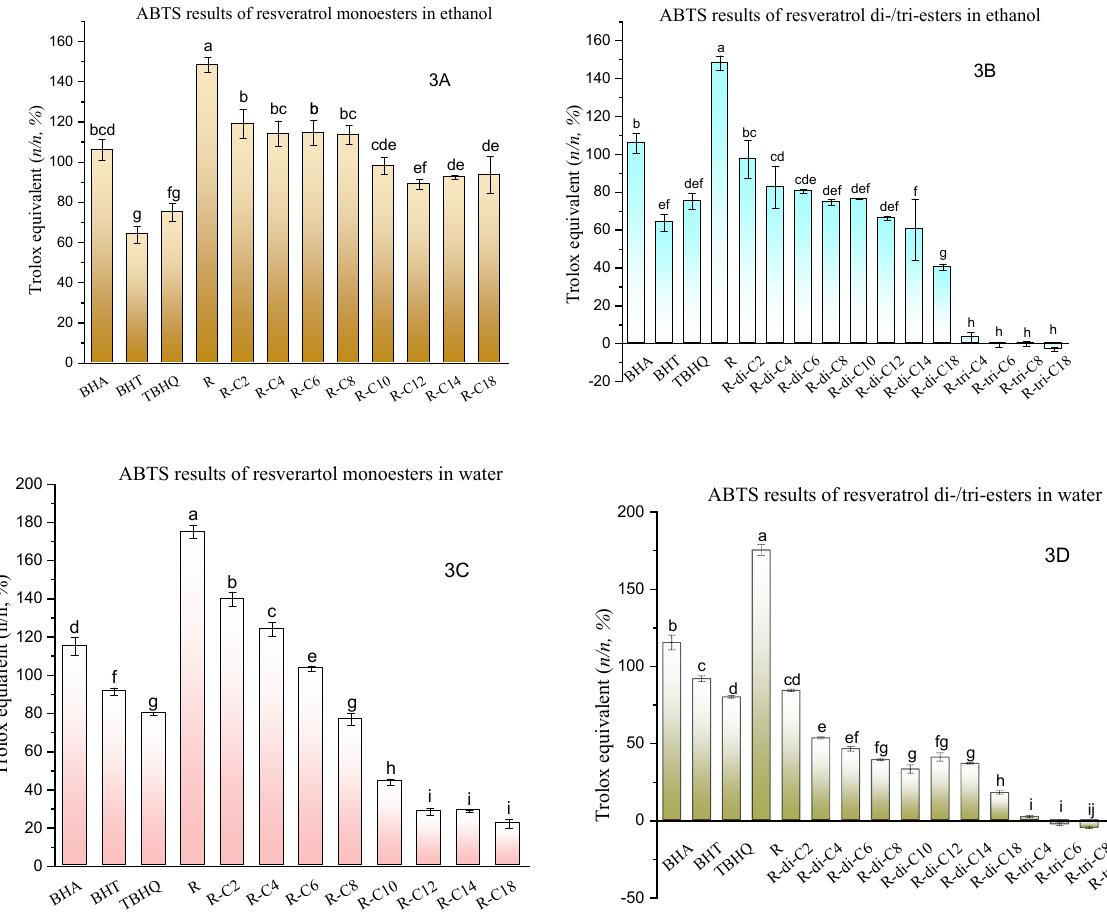
Figure 3. ABTS cation radical-scavenging capacity ( A ): ABTS radical scavenging capacity in mole efficacy equivalent of Trolox per mole of resveratrol (R) or its monoesters (%, n/n ) in ethanol system. R-C2, R-C4, R-C6, R-C8, R-C10, R-C12, R-C14, R-C18 are resveratrol esters of acetic acid, butyric, caproic, caprylic, capric, lauric, myristic, and stearic acids, respectively. ( B ): ABTS radical scavenging capacity in mole efficacy equivalent of Trolox per mole of resveratrol (R) or its di-/triesters (%, n/n ) in ethanol system. R-di-C2, R-di-C4, R-di-C6, R-di-C8, R-di-C10, R-di-C12, R-di-C14, and R-di-C18 are resveratrol diesters of acetic acid, butyric, caproic, caprylic, capric, lauric, myristic, and stearic acids, respectively; R-tri-C4, R-tri-C6, R-tri-C8, and R-tri-C18 are resveratrol triesters of caproic, caprylic, capric, and stearic acids, respectively. ( C ): ABTS radical scavenging capacity in mole efficacy equivalent of Trolox per mole of resveratrol (R) or its monoesters (%, n/n ) in water system.